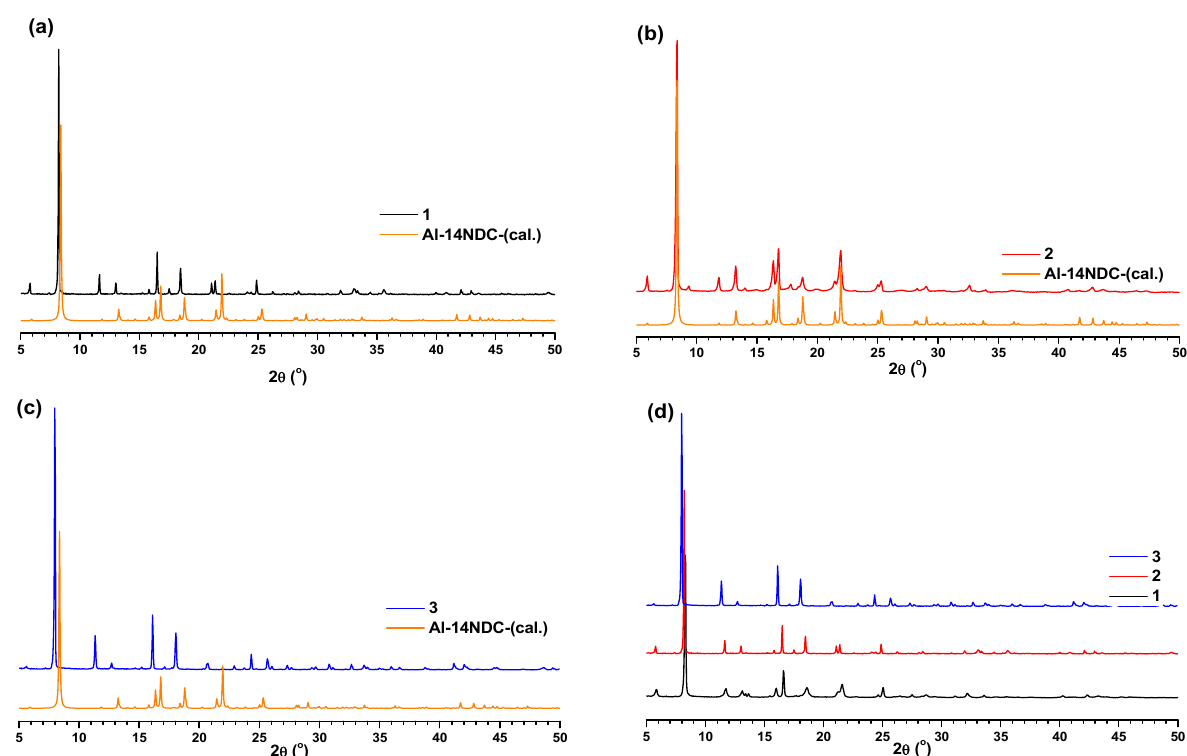
Figure 1. The comparison of PXRD patterns of as-synthesized MOFs, ( a ) 1 , ( b ) 2 and ( c ) 3 with simulated PXRD pattern of reported Al-1,4-NDC; ( d ) the comparison of PXRD patterns of activated MOFs.